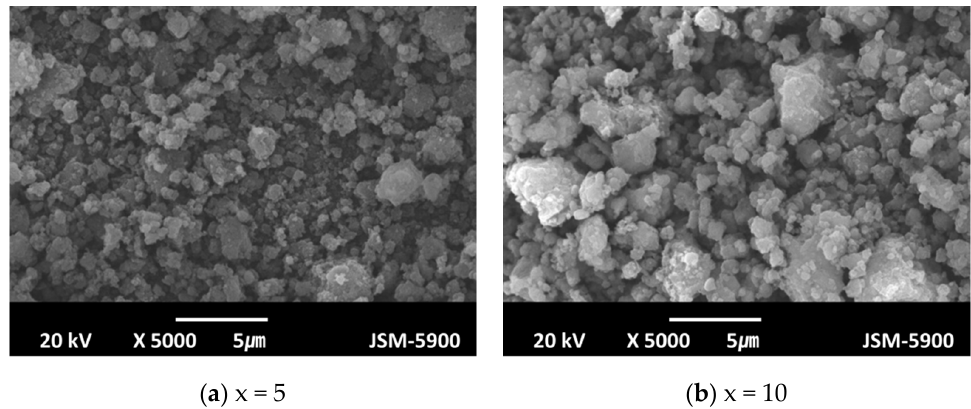
Figure 9. SEM micrographs of Mg-xMgH 2 -1.25Ni-1.25TaF 5 -1.25VCl 3 (x = 5 and 10) after four hydriding and dehydriding cycles; ( a ) x = 5 and ( b ) x = 10.